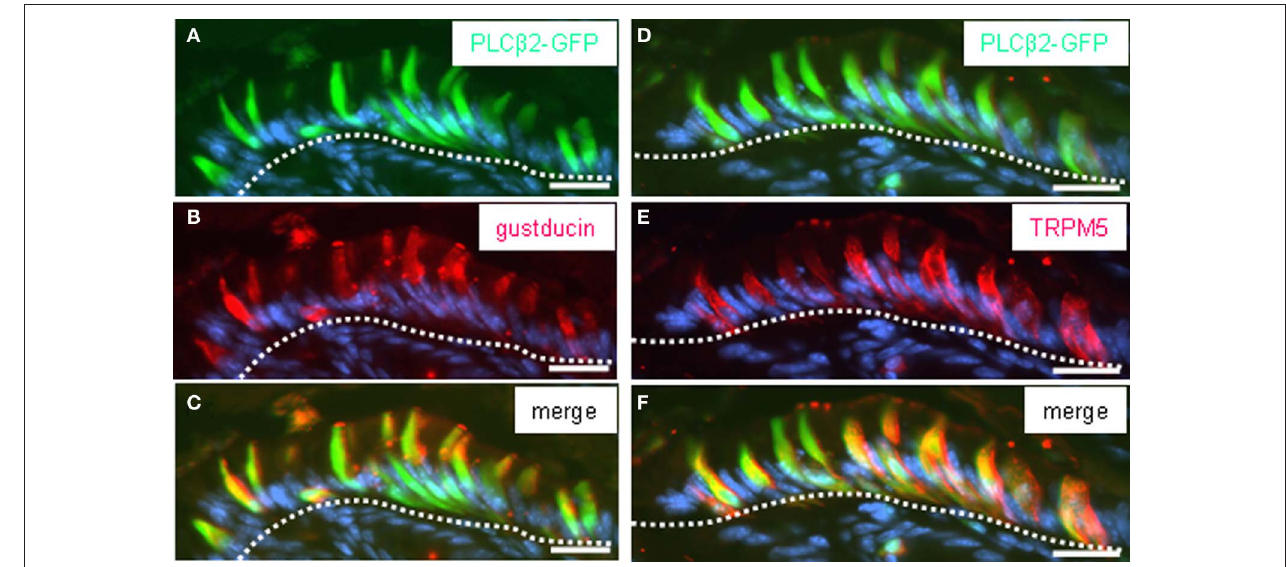
FIGURE 4 | PLC β 2-GFP-expressingcellsof the corpusmucosa underneath the “limitingridge”are immunoreactivefor gustducin and TRPM5. (A–C) Distribution patternof gustducin (red )was assessed on cross sections throughthecorpusmucosaadjoiningthefundustissueofPLC β 2promoter-GFP transgenicmice. The white dottedline bordersthe most apical cell layer from the residualcorpusmucosa.Cluster of cells immunostainedfor gustducin (B) underneaththe“limiting ridge”exhibitan elongatedcylindrical morphology and stronglylabeledapical microvilli tufts. Patternof intrinsic GFPfluorescence